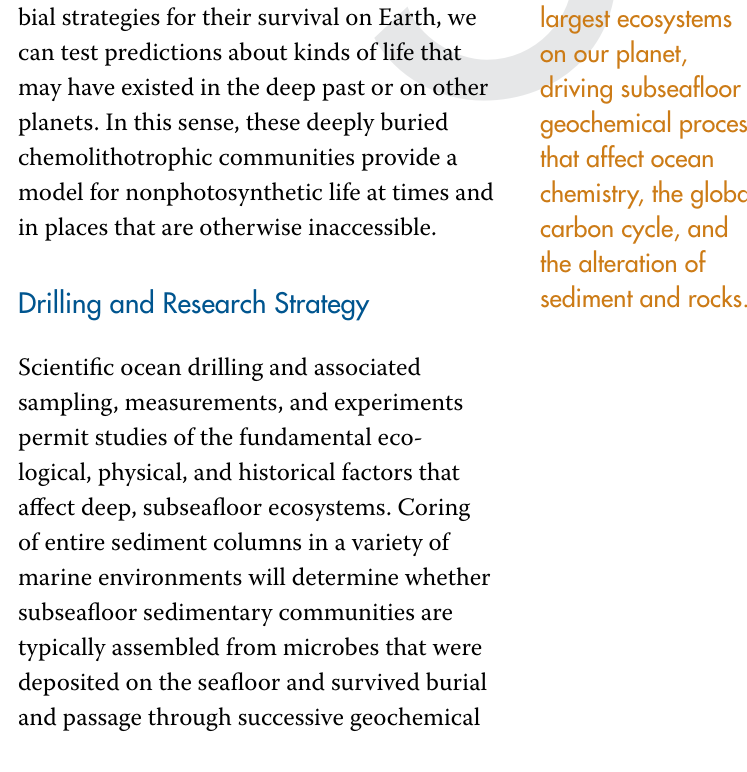
figure 3.2. cultivations of subseafloor sedimentary microbes using a flow-through bioreactor system customized for low energy and nutrient flux subseafloor envi- ronments. (a) The anaerobic bio- reactor system. phase-contrast microscopic image of archaeal isolates (B) Methanobacterium sp. and (d) Methanosarcina sp., and bacterial isolates (c) Chloroflexi sp. and (e) Sedimentibacter sp. all four strains were isolated from sediment cored at site c9001 during the Chikyu shakedown expedition off shimokita, Japan. innovative cultivation techniques will help scientific ocean drilling to open a window to understand- ing of genetic, metabolic, and evolutionary characteristics of subseafloor life. modified from imachi et al. (in